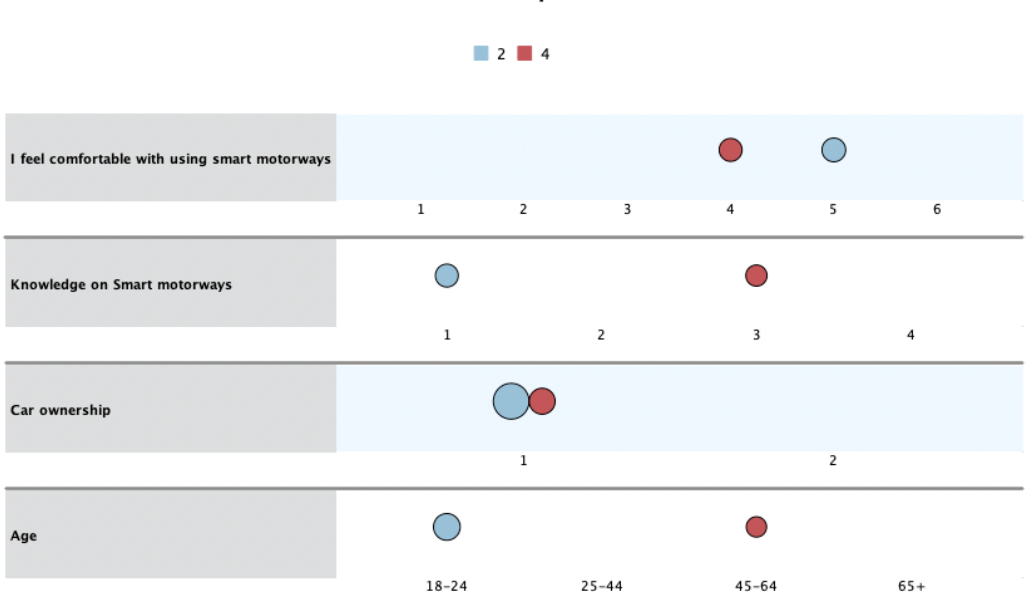
Figure 7 Car ownership and comfort driving the smart